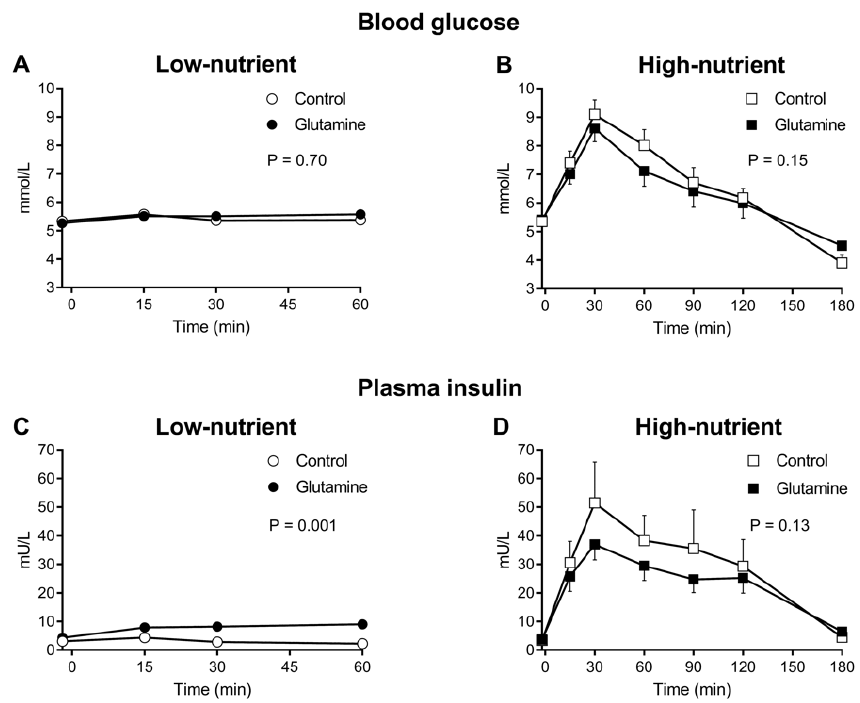
Figure 2. Effects of low-nutrient ( ○ ) and low- nutrient with glutamine (●) drinks (ANOVA, p = 0.70; ( A ) and high- nutrient (□) and high -nutrient with glutamine ( ■ ) drinks (ANOVA, p = 0.15; ( B ) on blood glucose. Effects of low-nutrient ( ○ ) and low-nutrient with glutamine ( ● ) drinks (ANOVA, p = 0.001; ( C ) and high- nutrient (□) and high -nutrient with glutamine ( ■ ) drinks (ANOVA, p = 0.13; ( D ) on plasma insulin. Data are mean values ± SEM represented by vertical bars.